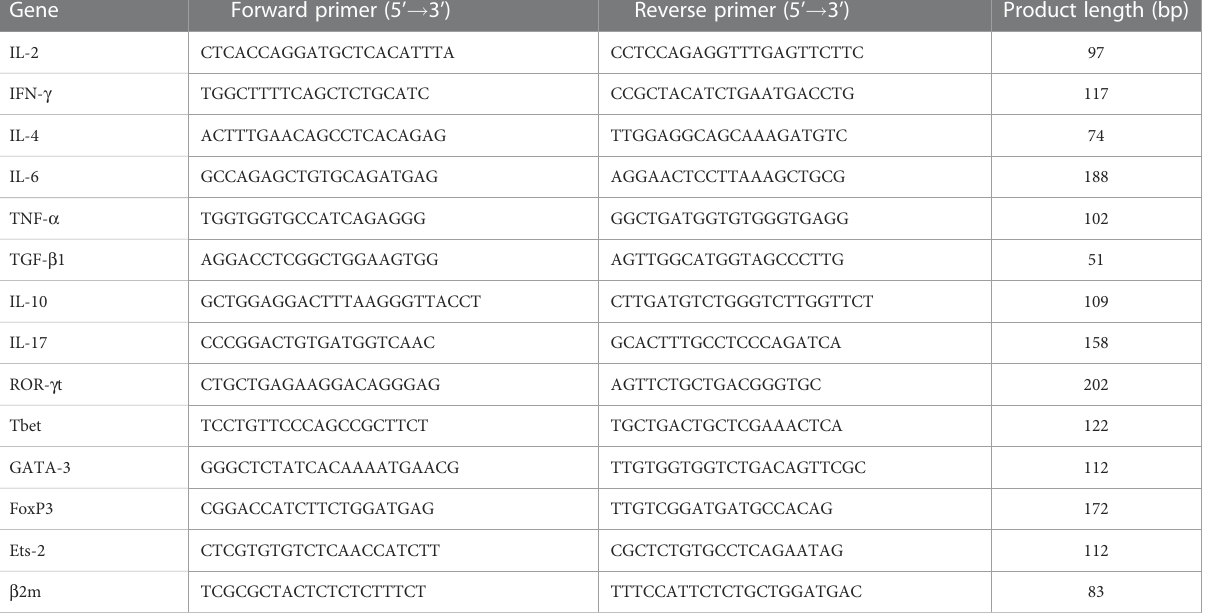
TABLE 2 Primer sequences used for